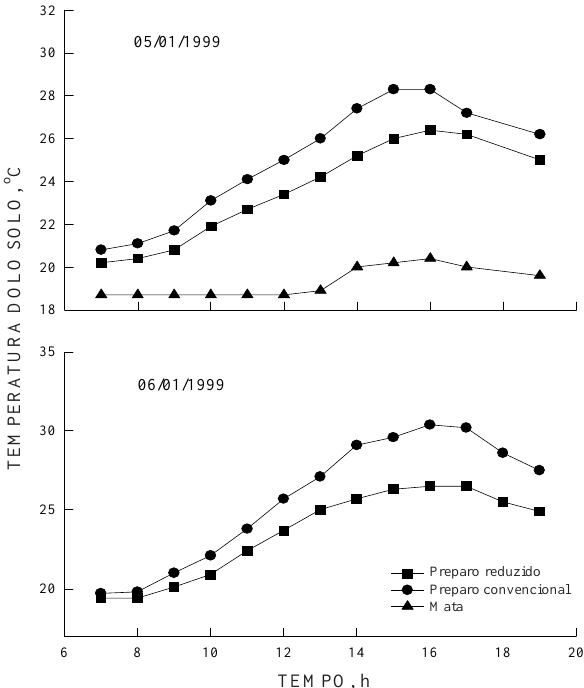
Figura 5. Oscilação da temperatura do solo na pro- fundidade de 0,05 m, das 7 às 19 h, no sistema de preparo reduzido, preparo convencional e mata nativa. Determinações realizadas nos dias 05 e 06 de janeiro de